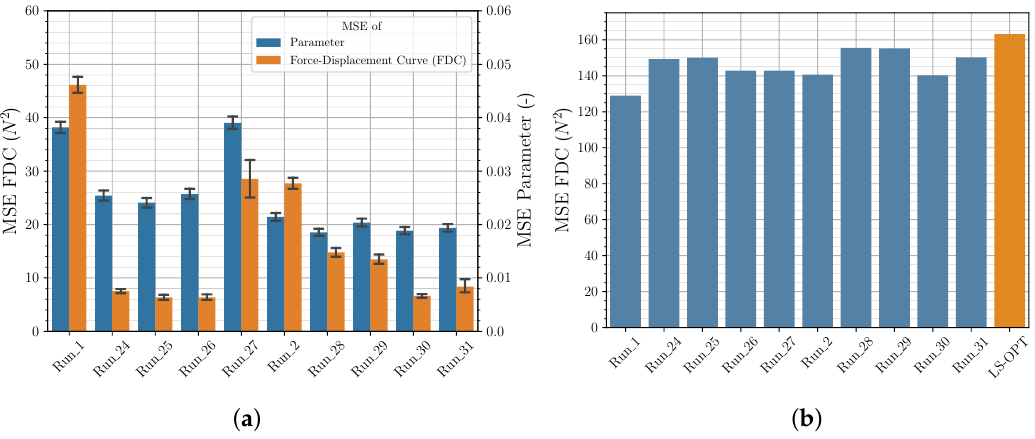
Figure 16. Comparison of MSE of FDC from ( a ) validation data and ( b ) experimental data for different NN from HP